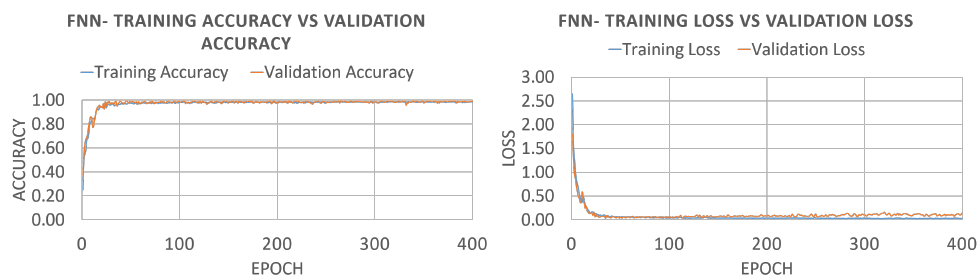
Figure 17. Comparison between the loss and accuracy for the FNN algorithm in both training and validation cycles.